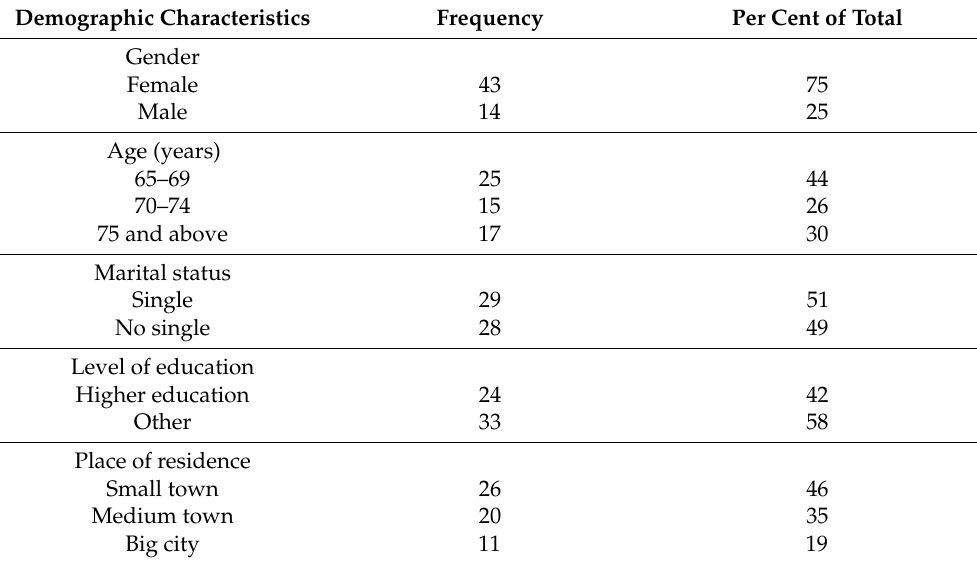
Table 1. Respondents’